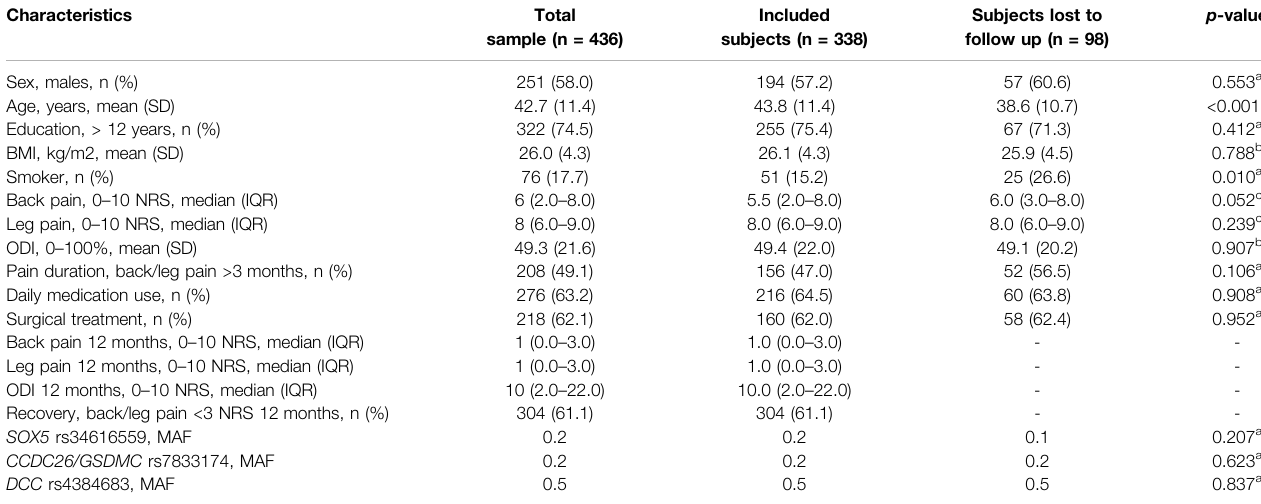
TABLE 1 | Sample characteristics for genotyped subjects ( n = 436) admitted to a secondary health-care institution due to an acute episode of LBP with radiculopathy. Comparison of subjects who responded to the follow-up questionnaire at 12 months with subjects who did not respond.